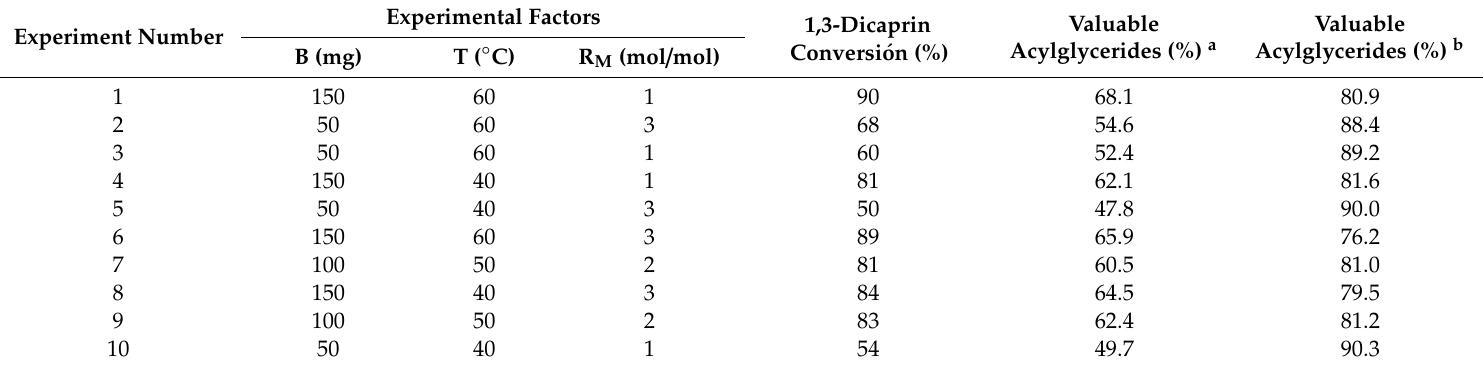
Table 4. Experimental factors and parameters evaluated during the enzymatic esterification of dicaprin with palmitic acid catalyzed by BCL / chitosan at 6 h of